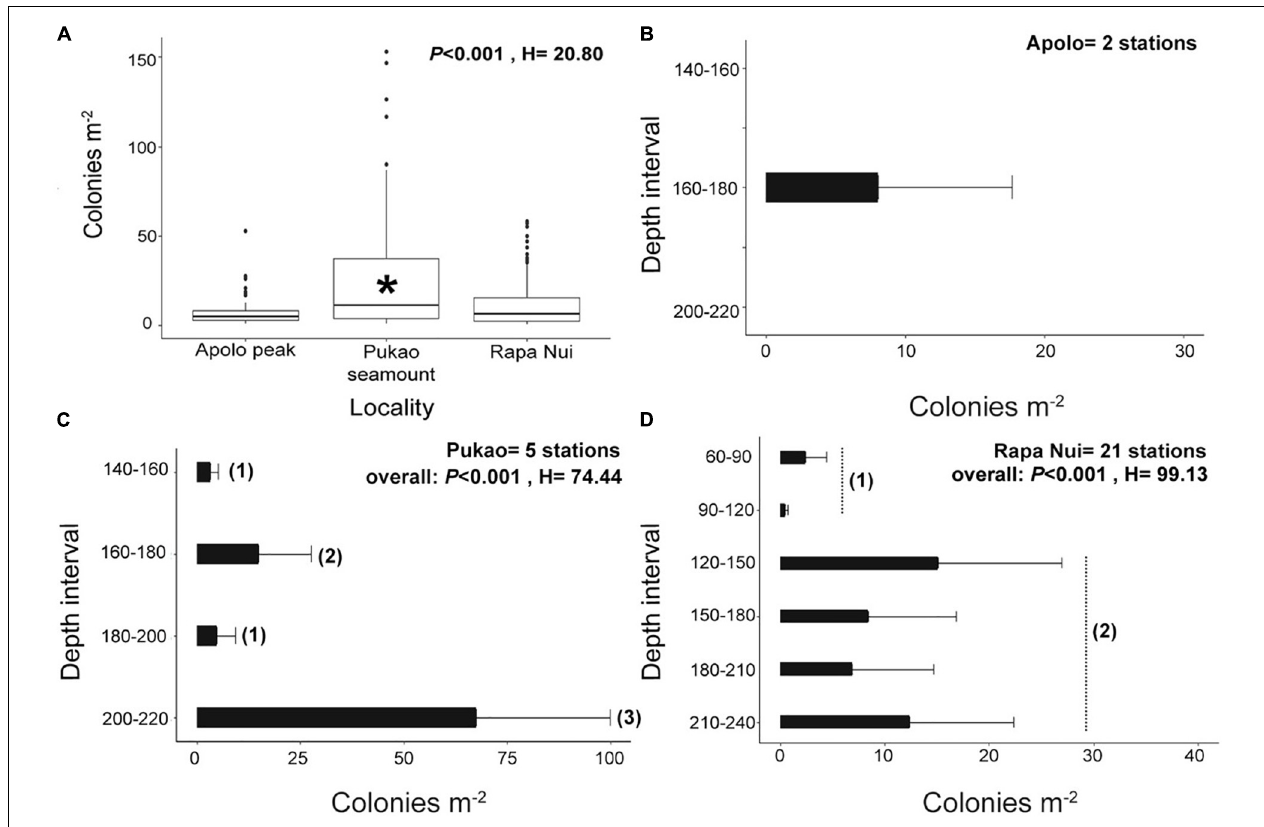
FIGURE 5 | (A) Box plots of total coral abundance (colonies m − 2 ) at each site. Box and whisker plots represent the 95% confidence interval. *Presents significant differences between the groups ( P < 0.001). (B–D) Total abundance (colonies m − 2 ± SE) of the whip black corals per depth interval on (B) Apolo peak, (C) Pukao seamount, and (D) around Rapa